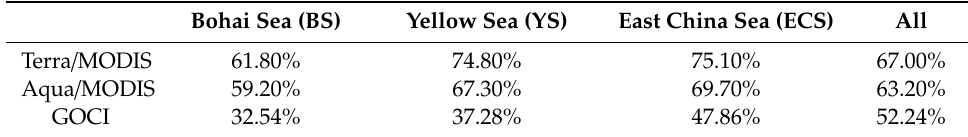
Table 5. Cloud coverage of Terra / Aqua MODIS imagery over China’s seas, compared to GOCI